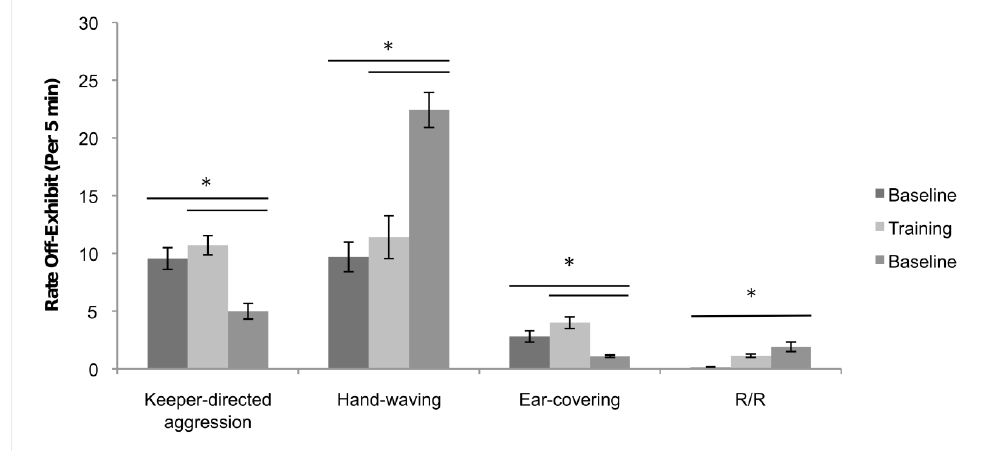
Figure 1. A) While on-exhibit no significant change in the rate of ear covering, hand waving or R/R was observed. B) During interaction sessions the subject’s rate of ear-covering, H (2) = 27.91, p < 0.001, and keeper-directed aggression, H (2) = 20.36, p < 0.05, significantly decreased in the second baseline. The subject’s rate of hand-waving, H (2) = 30.75, p < 0.001, and R/R, H (2) = 8.01, p = 0.018, however, significantly increased in the second